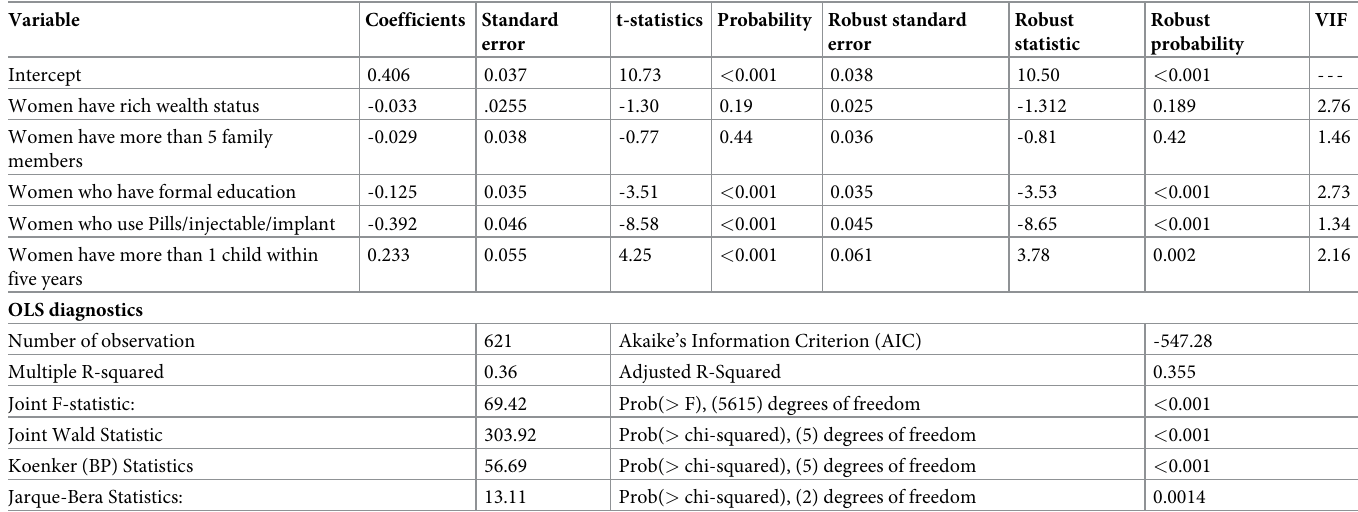
Table 5. Summary of OLS results and diagnostics for anemia among WRA in Ethiopia, EDHS 2016.